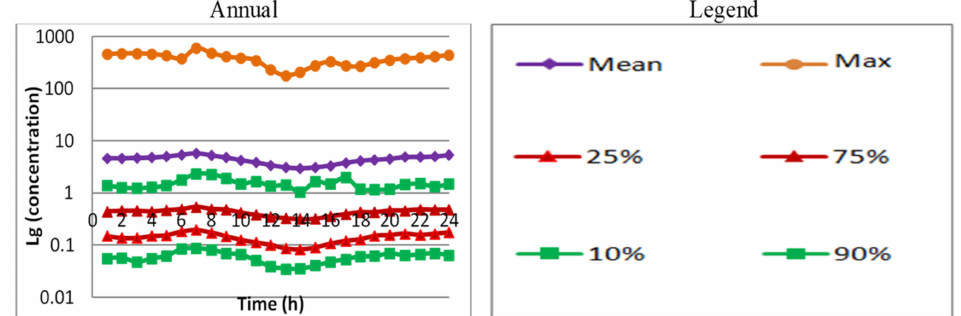
Figure 11. Spatial and diurnal variations of the annual and seasonal ensembles of surface FPRM ( µ g/m 3 ) concentrations behavior in logarithmic scale for Orlov most for the period 2008–2014.